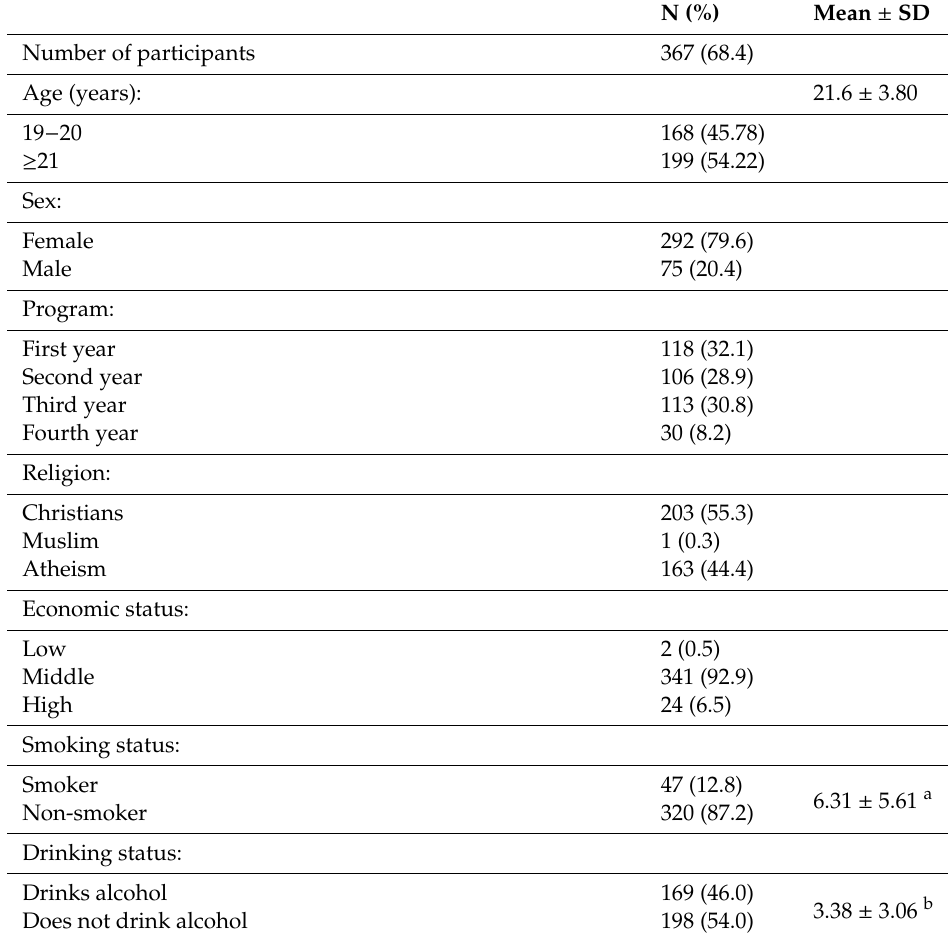
Table 1. Baseline characteristics of the study’s